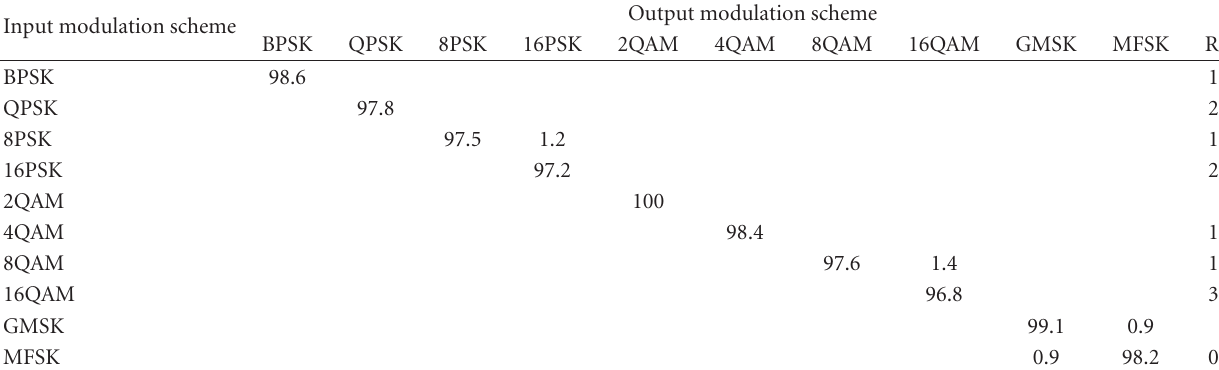
Table 3: Confusion matrix for SNR = 5 dB.